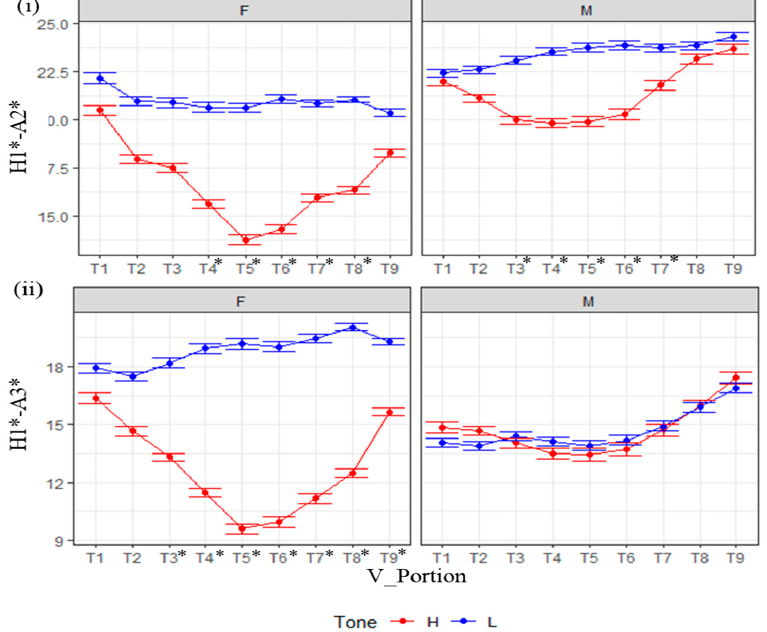
Figure 6. Scatter plots representing independent variables as a function of timepoints (T1 to T9) for ( i ) H1*–A2* and ( ii ) H1*–A3*. The asterisk (*) at each timepoint indicates significant interactions at a particular time point. F and M indicate female and male speakers’ data,